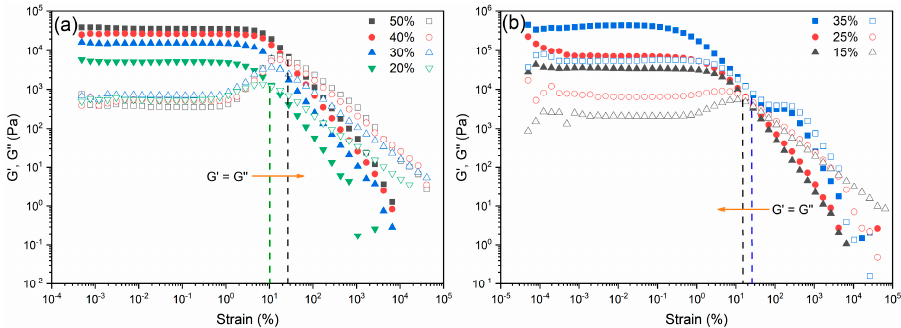
Figure 5. Linear viscoelastic region (LVR) of ( a ) Pluronic solutions and ( b ) glass inks measured under amplitude sweep mode. The elastic modulus (G’) and viscous modulus (G’’), independently plotted amplitude sweep mode. The elastic modulus (G (cid:48) ) and viscous modulus (G”), independently plotted in in the same axis, are labelled as solid dots and empty symbols, respectively. the same axis, are labelled as solid dots and empty symbols,